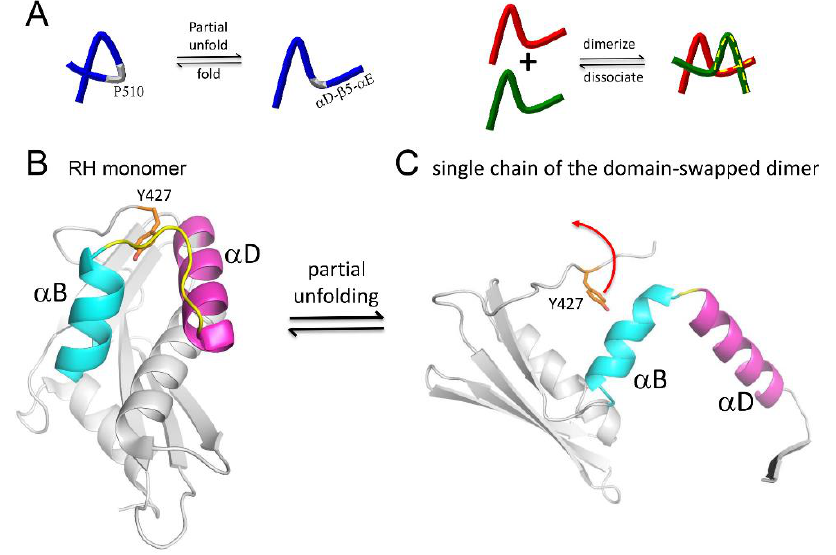
Figure 12. A domain-swapped structure of the RH domain reveals an unfolding pathway. ( A ) In the domain-swapped structure, the α B– α D loop becomes a hinge, allowing the released α D- β 5- α E structural elements to interact with a second monomer; ( B ) the α B– α D loop (yellow) in the RH monomer adopts a strained conformation involving shortened helices that are able to extend by the incorporation of loop residues upon the formation of the domain-swapped form; ( C ) One of the monomer units of the domain-swapped dimer, showing the extended α B and α D helices and shortened hinge loop .